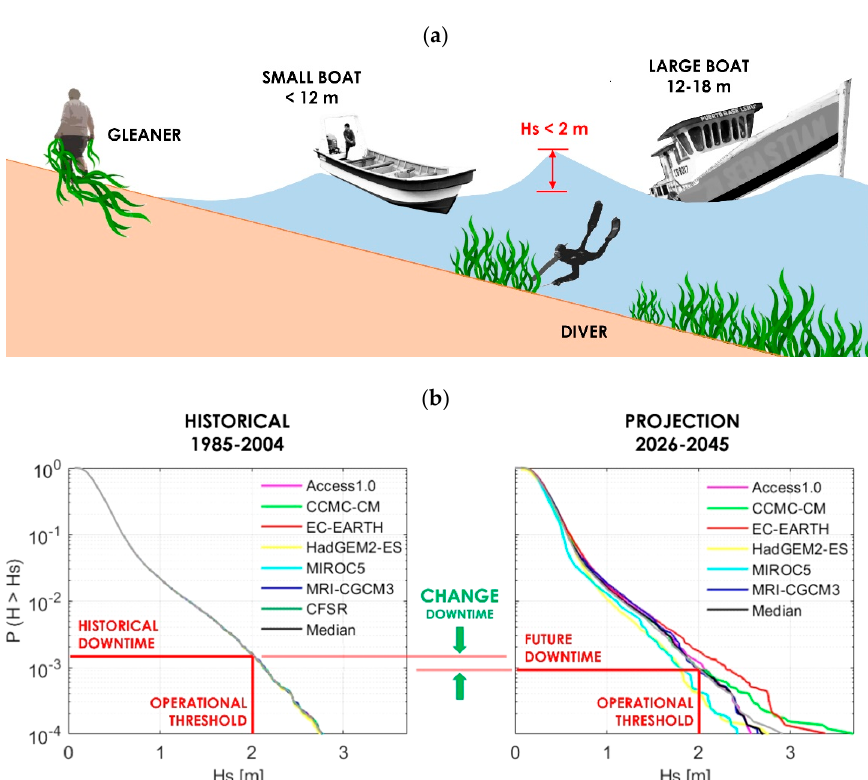
Figure 4. ( a ) Fishing activities analyzed in this study. ( b ) Computation of operational downtime in coves. Exceedance probability curves of unbiased values of significant wave height for the historical period (1985–2004) and mid-century (2026–2045) projection for six GCMs were used to compute the model median. The operational threshold of Hs = 2.0 m was used then to compute the historical and future downtime, the difference of which was used to compute the hazard. Note that, due to the application of the bias correction based on the Lemos et al. (2020) EGQM method, all curves collapsed into the benchmark (CFSR). For this specific example, downtime was reduced.